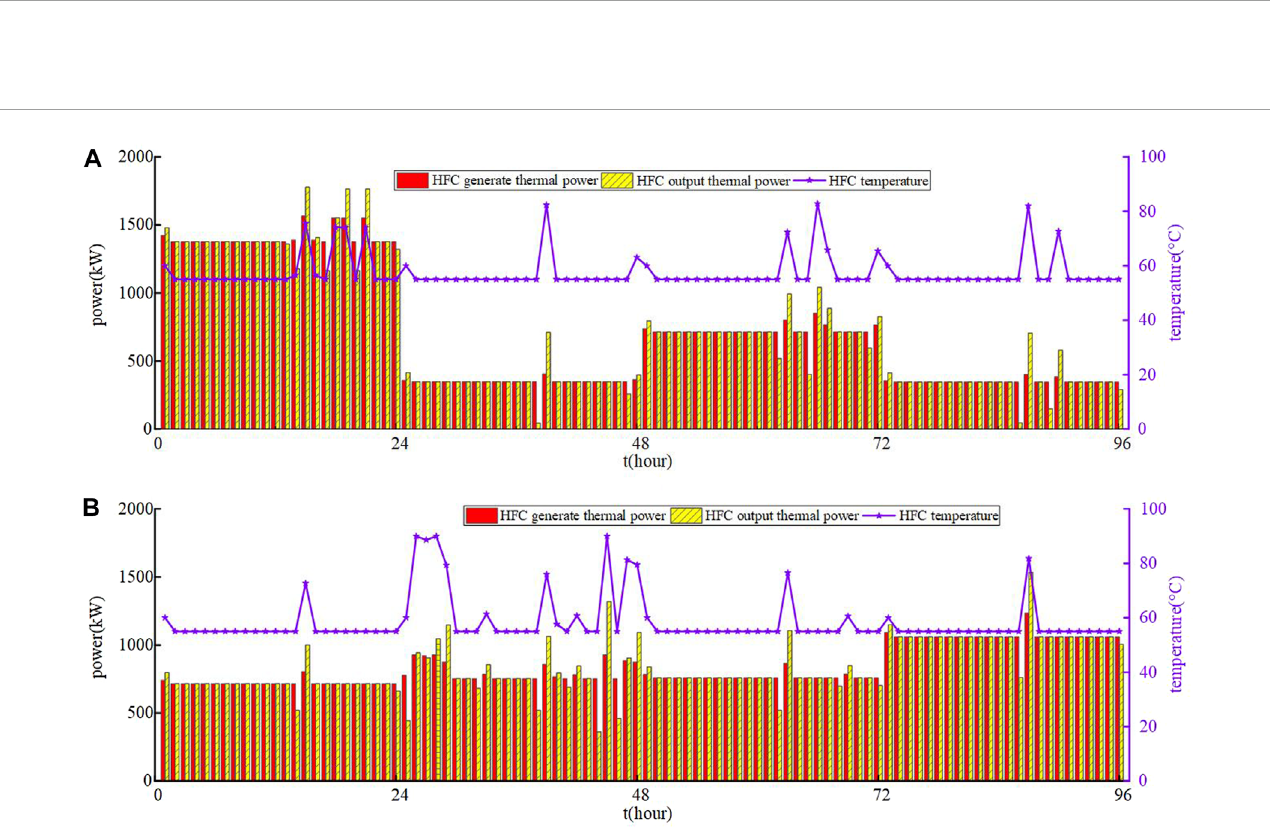
FIGURE 9 The relationship between thermal energy and temperature of HFC. (A) Case 1. (B) Case 2.